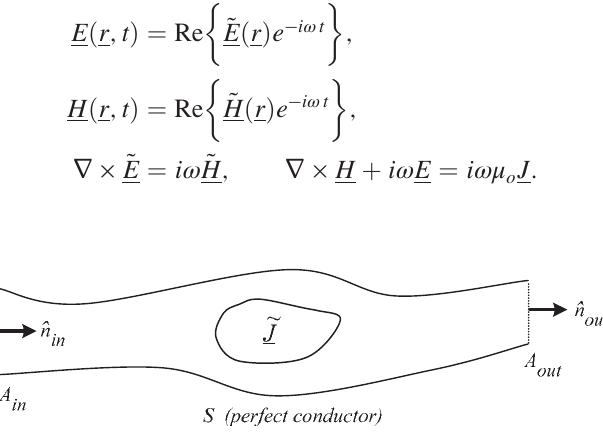
FIG. 1. Schematic of a general electromagnetic structure with ~ J excitation currents ð r Þ and perfectly conducting surfaces S (except for A and A in out